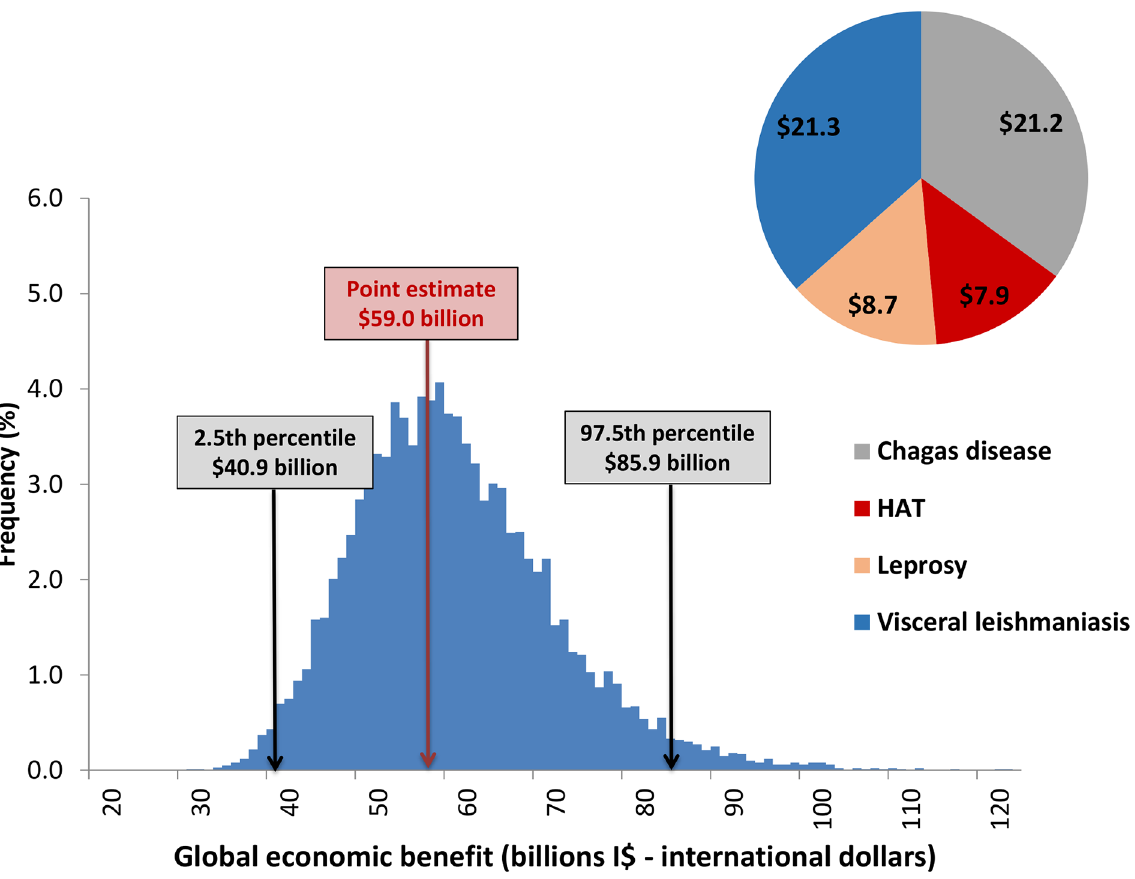
Fig 4. Global economic benefit (productivity loss averted) for IDM NTDs, for the period 2011–2030 (billions I$—International dollars). Global economic benefit from reaching the targets for IDM NTDs, lower and upper estimates from sensitivity analysis. Global economic benefit per